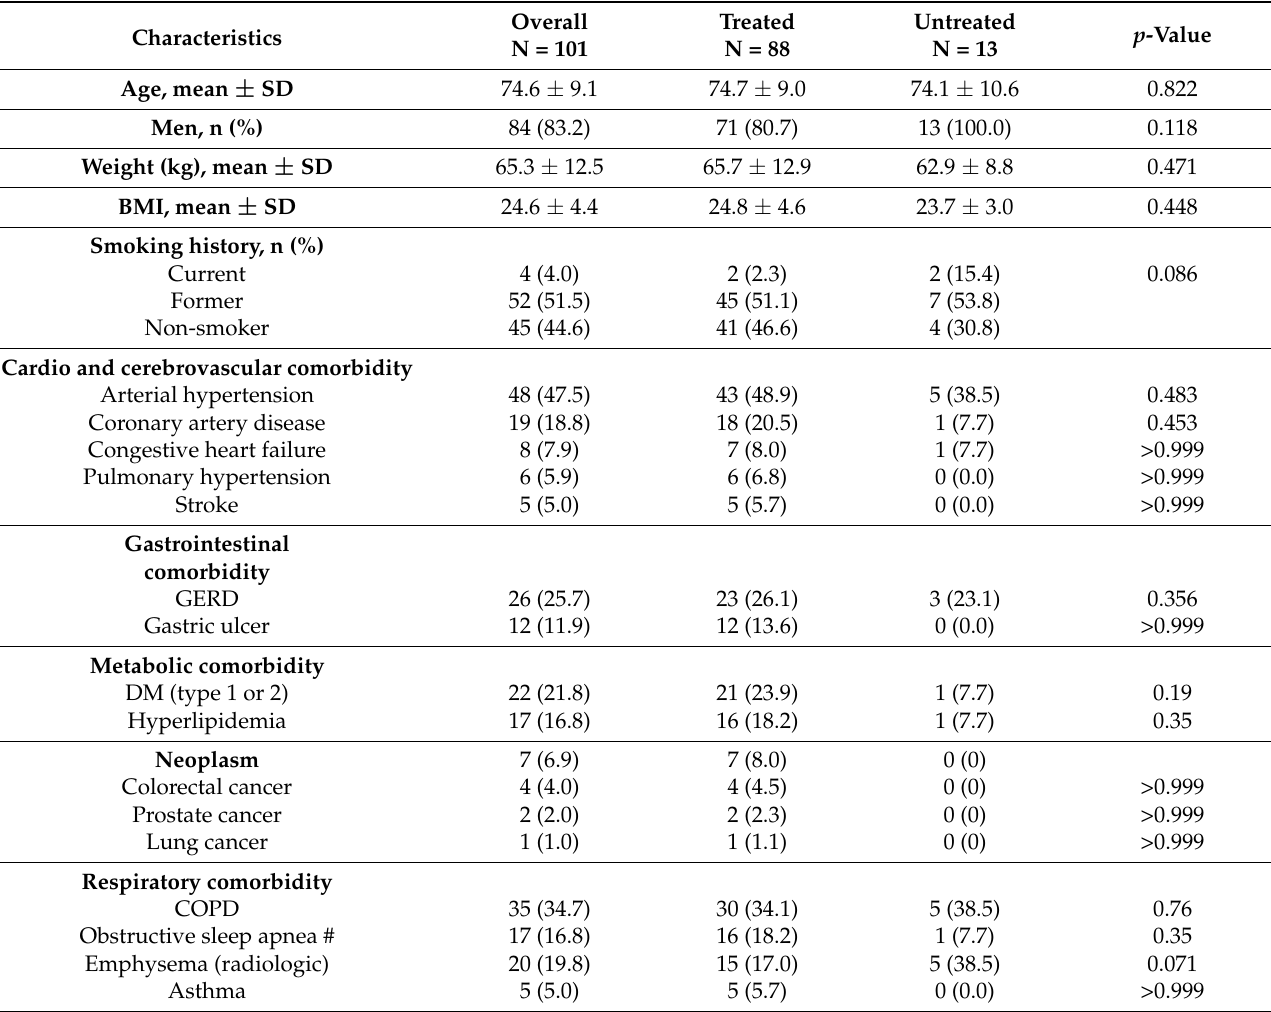
Table 1. Details of patient demographics and frequently observed comorbidities at the time of